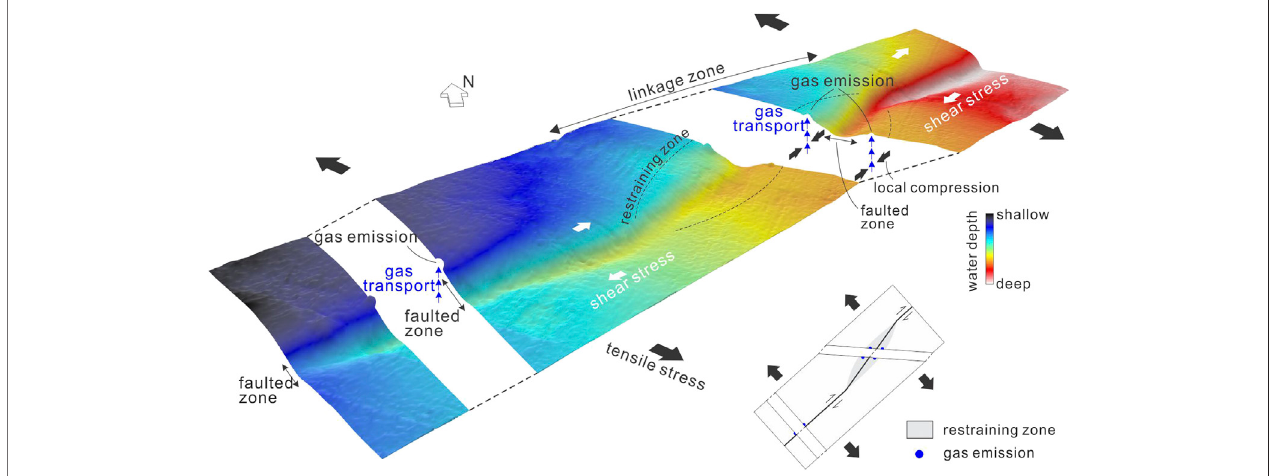
FIGURE 10 | Conceptual model showing the gas emissions in the transtensile regime. Inset shows the locations of the restraining zone and the gas emissions in plan view.